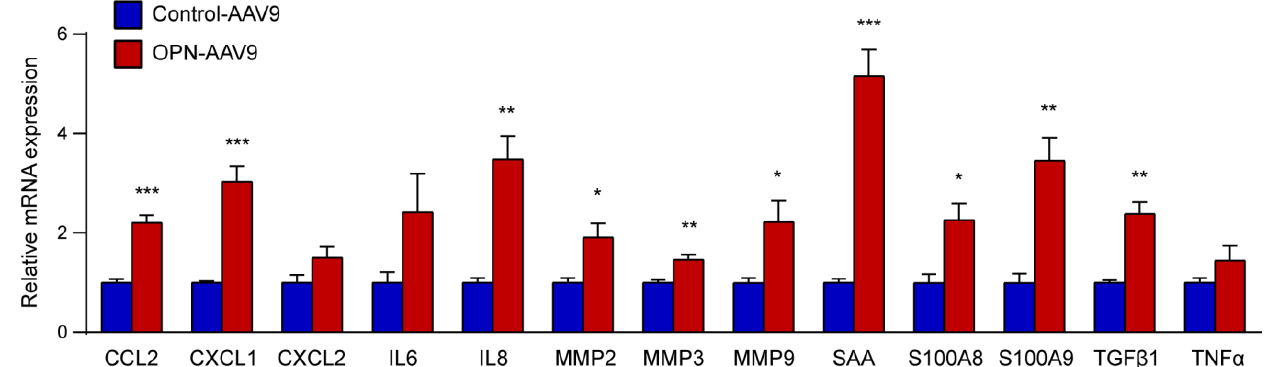
Figure 3. Circulating OPN increase enhances the expression of multiple factors linked to tumour development. RNA was isolated from the lungs of mice transduced with 5 × 10 10 control or OPN- expressing AAVs. The expression of the indicated transcripts was assessed by qPCR. For each transcript, the control and OPN groups were compared using Student’s t -test; n = 4 for all groups. * p < 0.05, ** p < 0.01, *** p < 0.001.